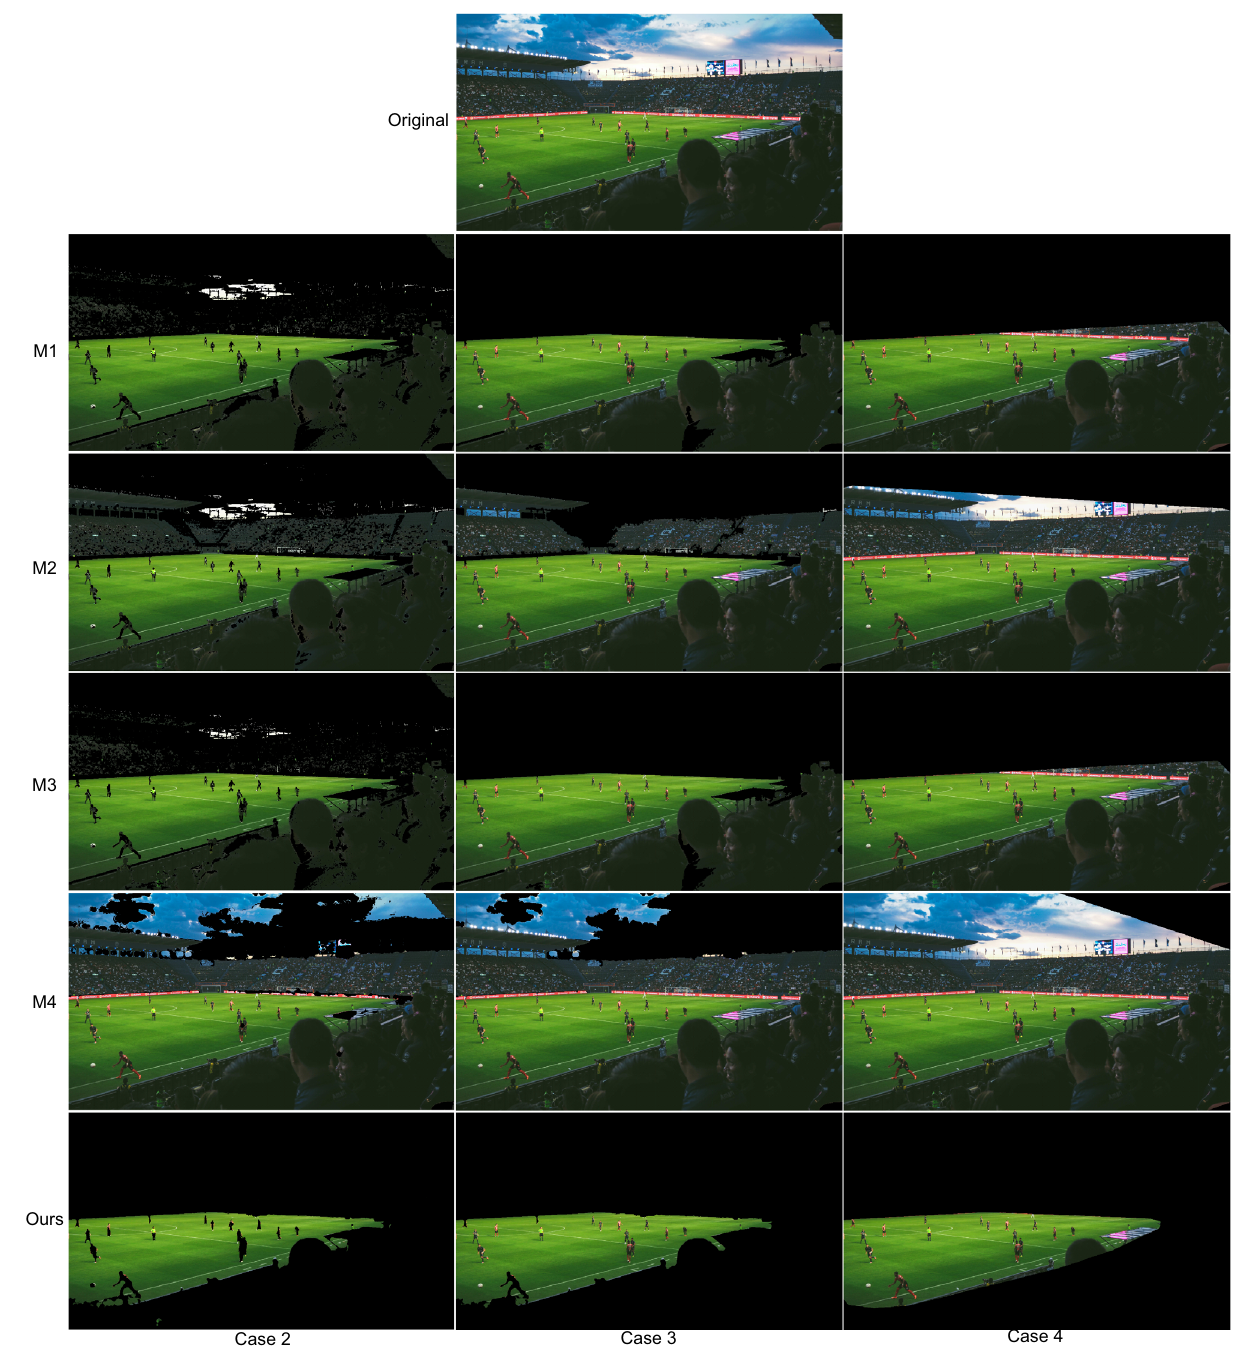
Figure 12. Results obtained in an image with poor color information in the stands. Original image from 46